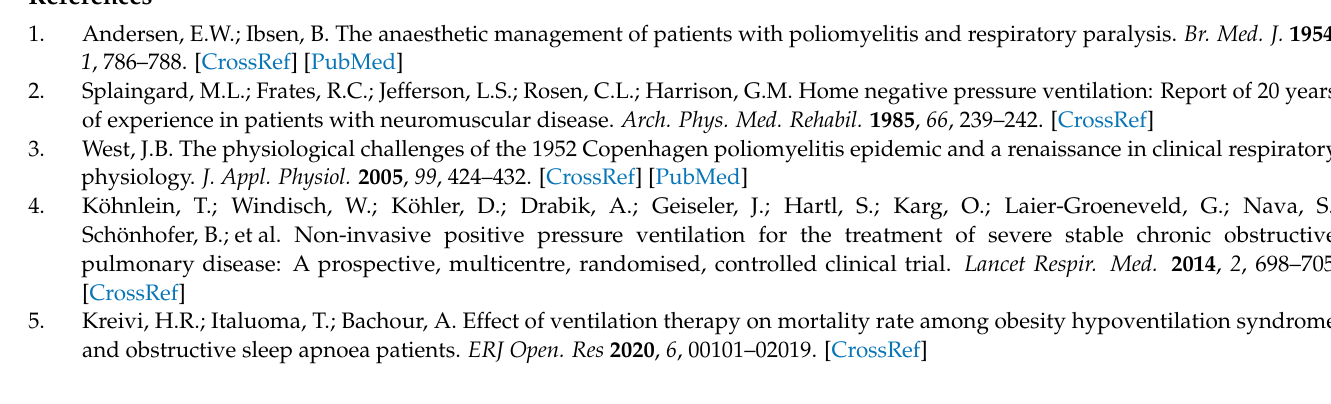
Table S4: Number (percentage) of mechanically ventilated adult patients acc. to condition and the method of ventilation in the years